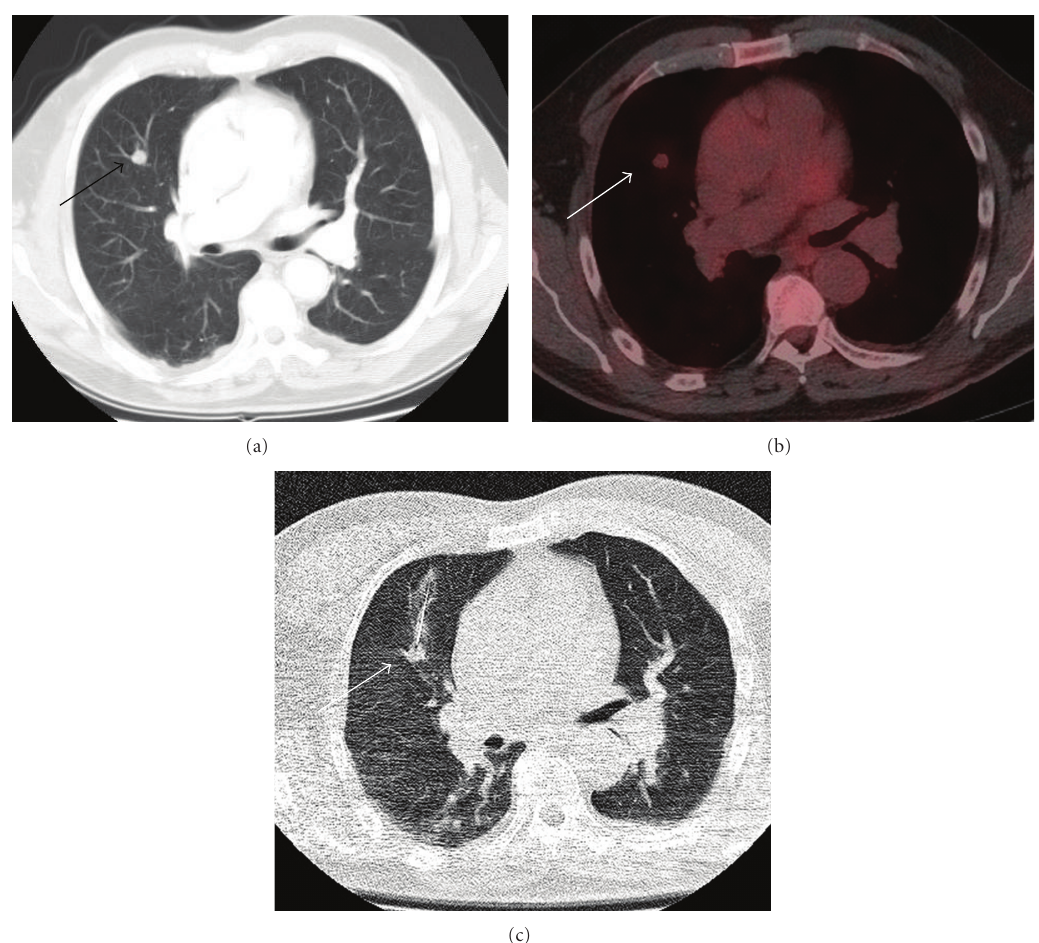
Figure 7: Patient with rectal carcinoma and mildly FDG avid metastases to lung. (a) There is a suspicious right upper lobe lung nodule (arrow) on CT in a patient with prior history of rectal carcinoma. (b) The lesion is only mildly FDG avid (arrow) on fused PET-CT. Based on these images the lesion is not definitively malignant. This may be due to the limited resolution of PET and the small lesion size or reduced cellularity. (c) Lung biopsy was subsequently performed confirming that the lesion (arrow) represented a metastatic deposit from rectal